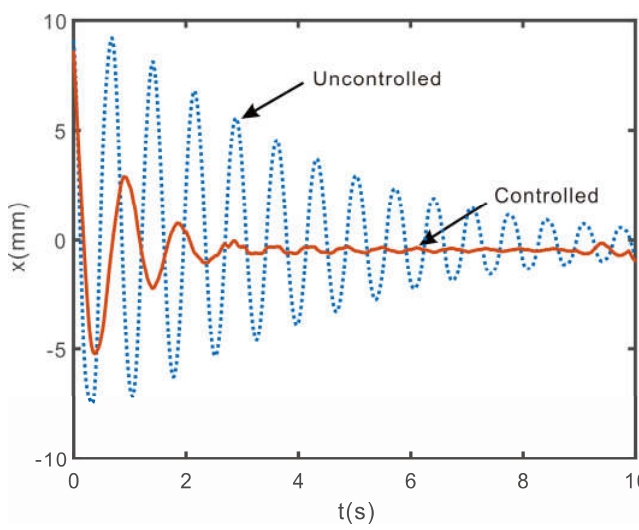
Figure 19. Free vibration experiment (the first mode excited).